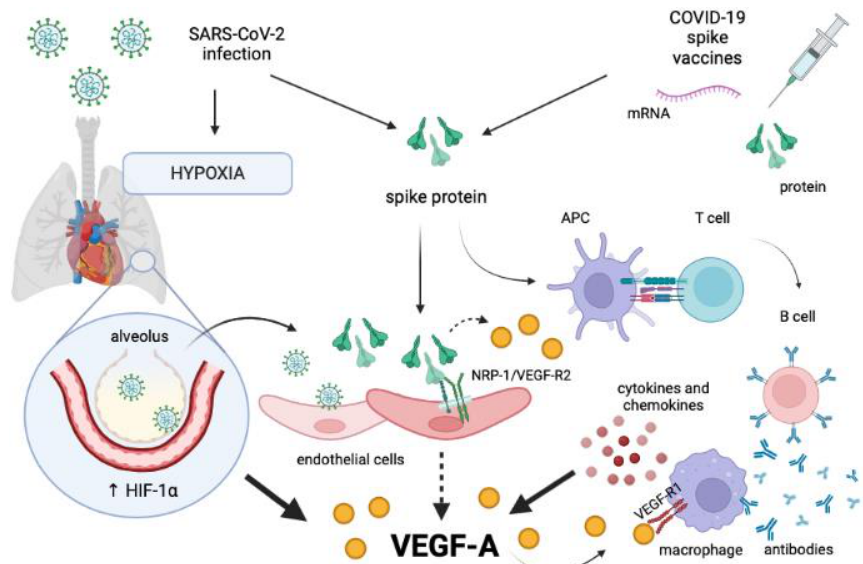
Figure 3. Hypothetical cascade of events triggered by SARS-CoV-2 S protein leading to overproduction of VEGF-A. The S protein produced by the virus during infection or used for vaccine immunization may induce the upregulation of VEGF-A in several ways. SARS-CoV-2 infection of pulmonary alveoli may result in hypoxia and local hyperexpression of HIF-1 α , which is a potent trigger for VEGF-A release. Furthermore, during COVID-19 and following vaccination, the S protein can activate both the innate and acquired immune response, with the final secretion of cytokines from monocyte/macrophages. This event may be enhanced by the binding of anti-spike antibodies to the FcRs of these cells. The release of proinflammatory cytokines may further contribute to the increase in VEGF-A levels. Additionally, it may be supposed that the S protein may bind to NRP-1 in endothelial cells and destabilize the NRP-1/VEGF-R2 receptor complex, eventually preventing the docking to the endogenous ligand VEGF-A. Unbounded VEGF-A could be diverted to VEGF-R1 expressed on immune cells, amplifying the inflammatory background. Abbreviations: APC: antigen-presenting cell; COVID-19: coronavirus disease-19; HIF-1 α : hypoxia-inducible factor 1 α ; NRP-1: neuropilin-1; VEGF-A: vascular endothelial growth factor A; VEGF-R1: vascular endothelial growth factor receptor 1; VEGF-R2: vascular endothelial growth factor receptor 2. Created with BioRender.com.